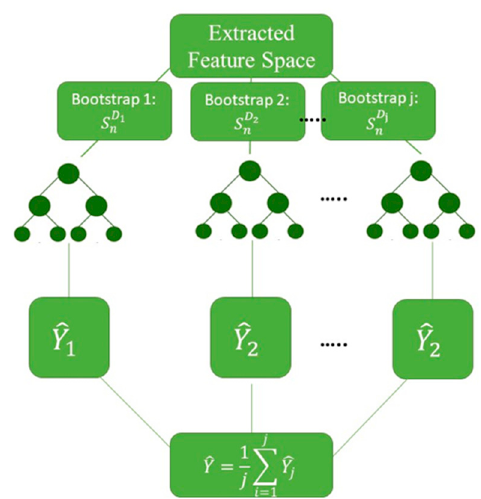
Figure 1 . Schematic structure of a random forest regression model. Figure 1. Schematic structure of a random forest regression